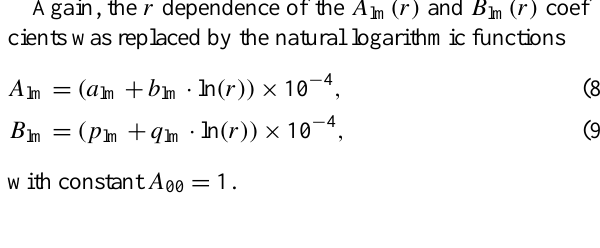
Figure 10. Geocoronal H-density distributions for solar minimum (top) and solar maximum (bottom) as ecliptic cut (left) and polar- meridional cut (right). Density contours for all four images from outside to inside: 45, 75, 100, 150, 225, 337 and 600 [cm − 3 ]. The yellow circles at 8 R e indicate the upper validity range of the model. Density contours at larger distances ( > 8 R e ) are model- extrapolated and therefore colored light-grey. Table 2. Near-solar-maximum 2012 model fit coefficients. The A lm and B lm coefficients (with the exception of A 00 ) have to be multi- plied by 10 − 4